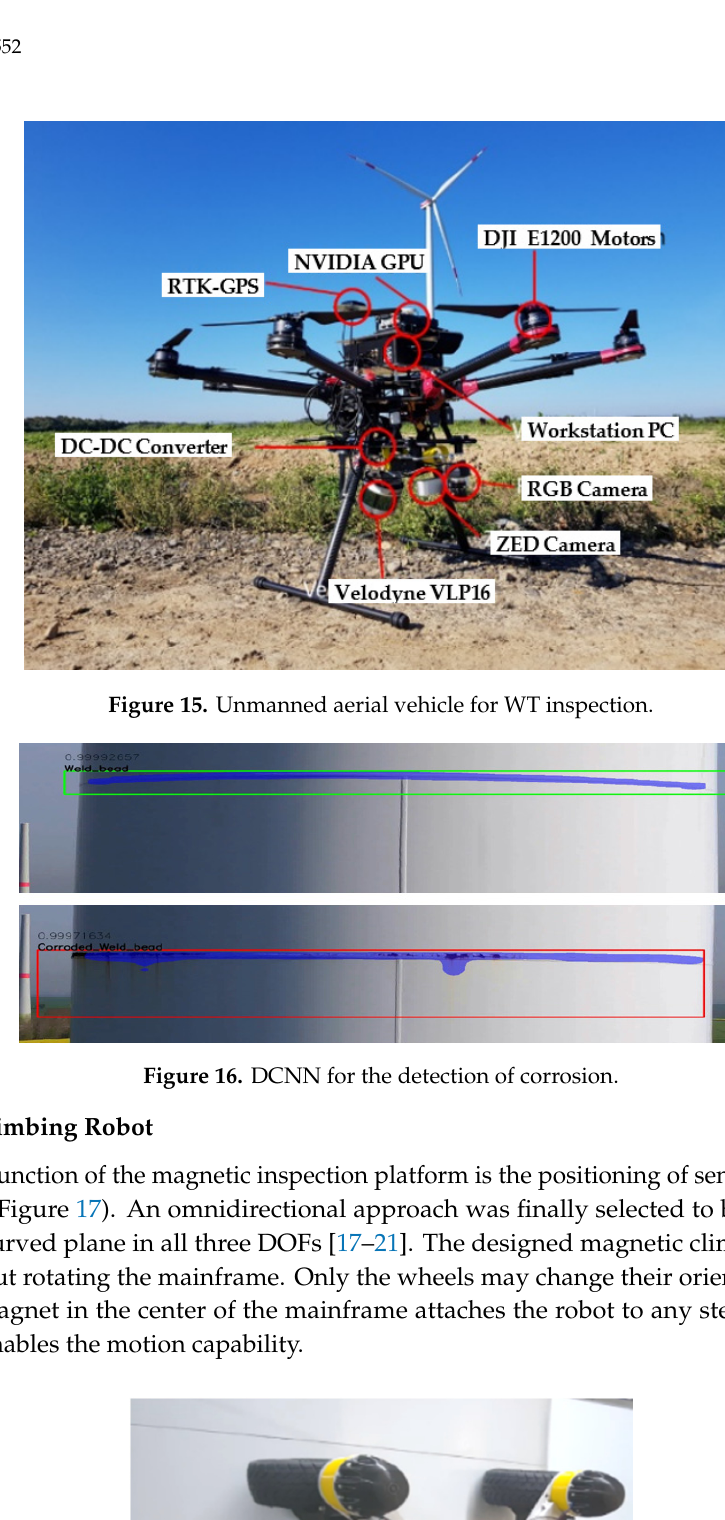
Figure 16. DCNN for the detection of corrosion.